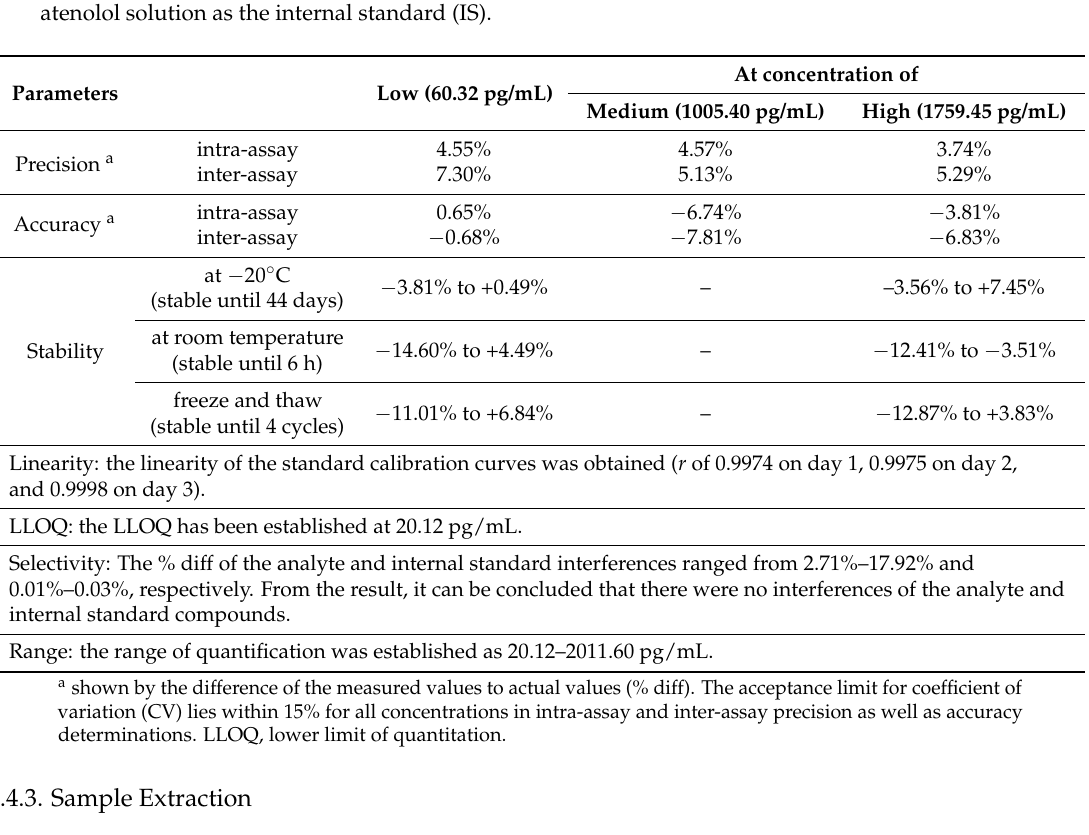
Table 1. Validation data of the analytical method used for the determination of pramipexole in human plasma via ultra performance liquid chromatography with mass spectrometry (UPLC-MS/MS), using atenolol solution as the internal standard